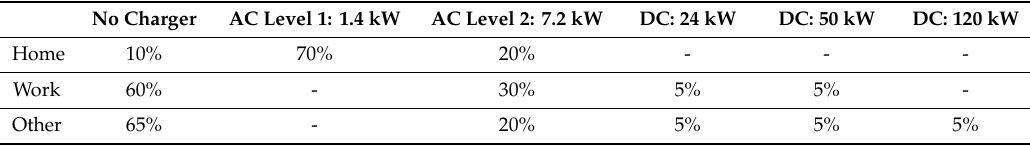
Table 4. Charging Infrastructure Assumptions for Modeling Year